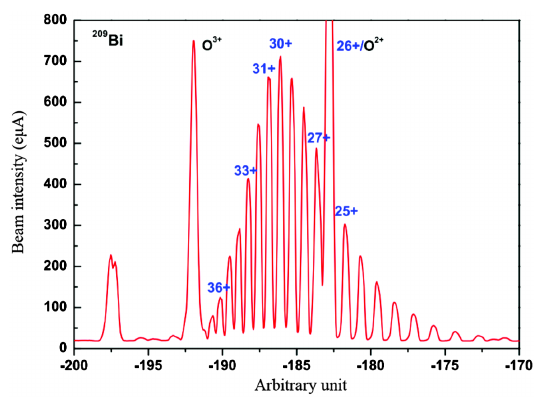
FIG. 13. Charge state distribution of the initial mixed beam (Bi and O) in the